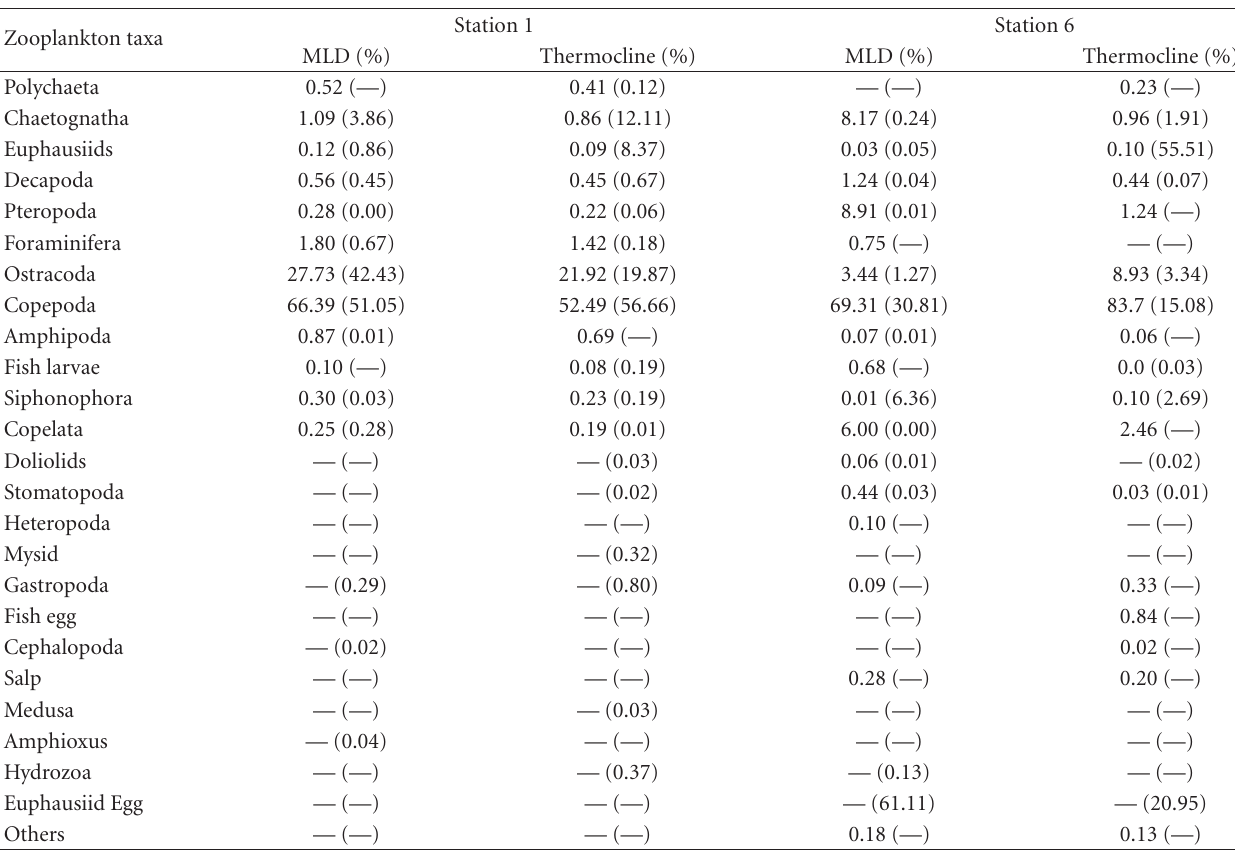
Table 3: Percentage composition of various zooplankton taxa in the MLD and thermocline layer during early and peak phases of summer monsoon at station 1 and 6 (values in the parentheses denotes the peak